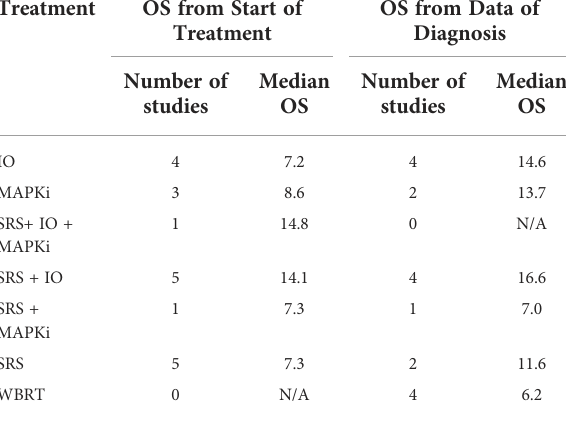
(Table 2, Figure S6) (39, 41, 42). For MAPKi vs. no MAPKi,